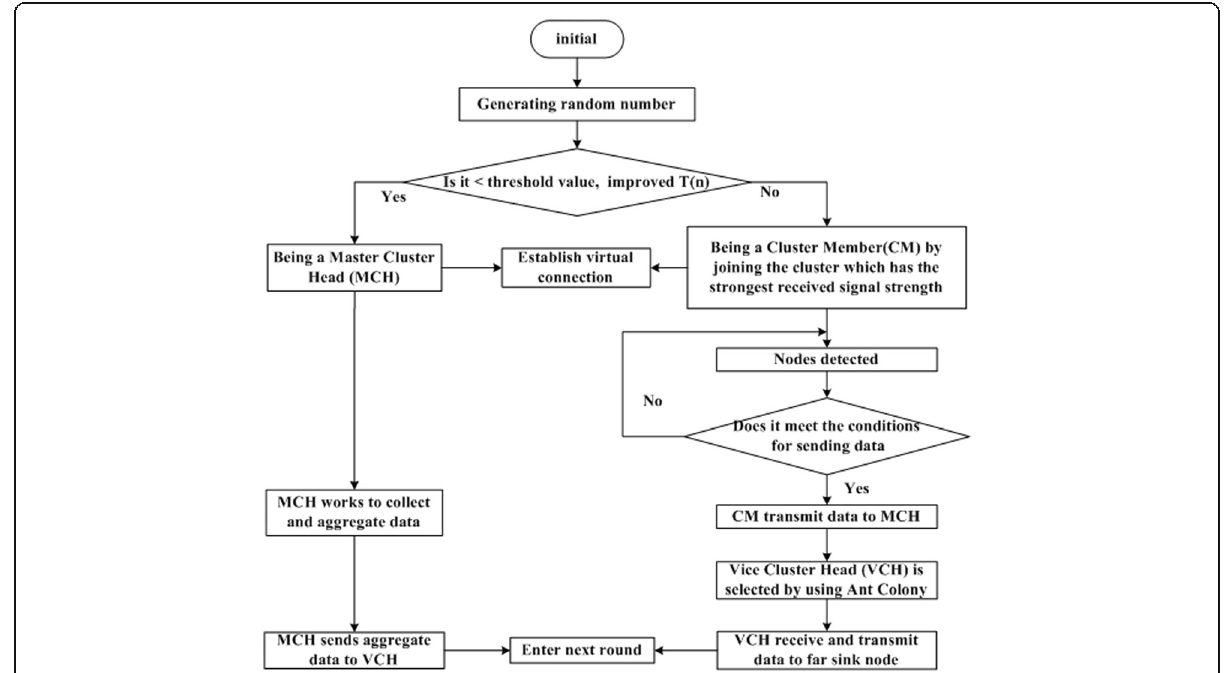
Fig. 3 Flow of the ADCAPTEEN protocol. The generated random number is compared with the formula threshold to determine MCH. The non-MCH node sends a join request to the MCH with the strongest received signal to become the cluster CM. Nodes are divided dynamically into several clusters. A virtual link between the MCH and the CMs is established. MCH selects the CM node with the largest pheromone concentration on the link as VCH. Once VCH is selected, it will not change until it enters the next round. CM sends the sensed data to MCH in its allocated TDMA slot. When MCH receives the data from all the CMs, it collects and aggregates data and sends the merging message to VCH which receives and transmits the merging message to far sink node